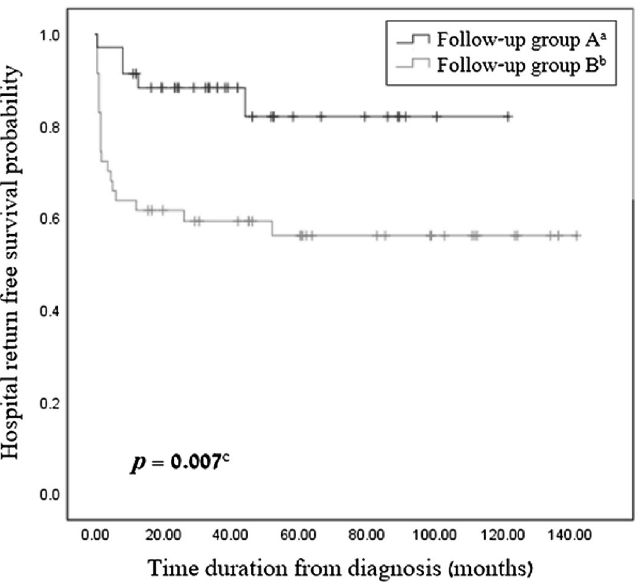
Figure 3. Incidence of IIH-related first unscheduled hospital visit in pediatric population. Kaplan–Meier survival analysis describes the incidence of IIH-related unscheduled hospital return of children diagnosed with IIH that were followed up continuously in tertiary center (follow-up group A) and children with another follow-up or no follow-up at all (follow-up group B). a Continuous follow-up in tertiary center; b Follow-up in community clinics or no follow-up at all; c Log-rank